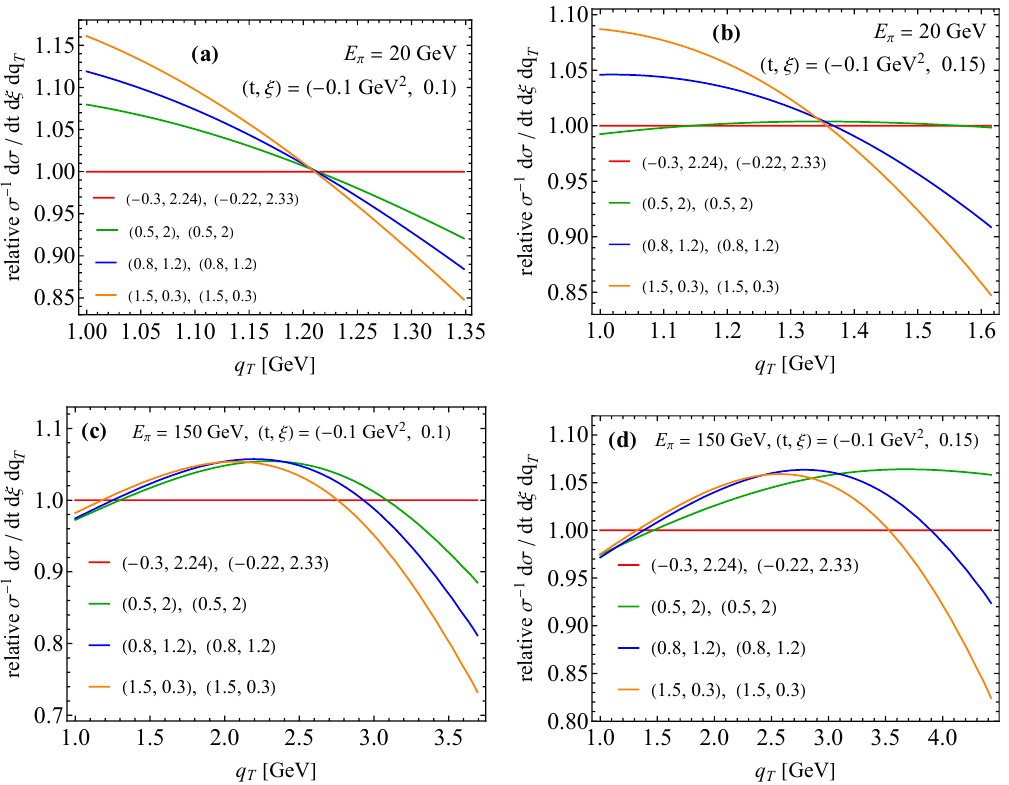
Figure 25. Ratio of normalized differential cross sections σ − 1 d σ/ d t d ξ d q T as a function of observed photon q T evaluated with the GPD model in eq. (4.14). Different curves correspond to different parameter sets of the GPD model in eq.